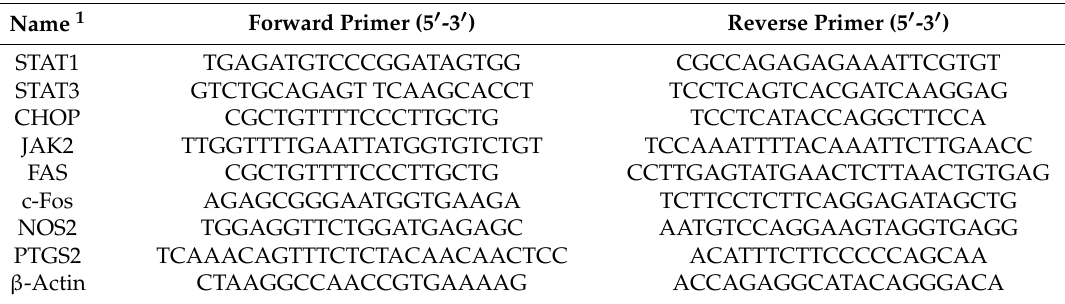
Table 1. Primers used for RT-PCR